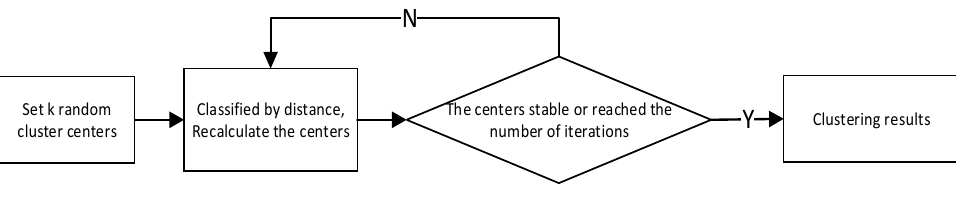
Figure 7. k-means clustering process.